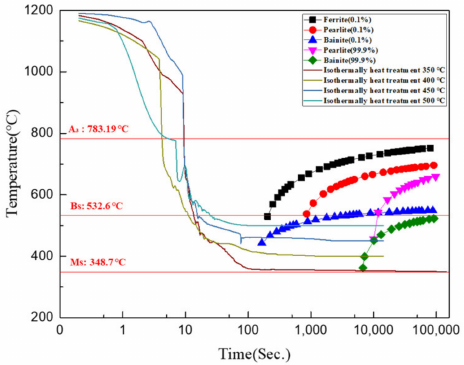
Figure 2. The temperature of the specimen measured during isothermal heat treatment based on the CCT curve calculated with Jmatpro was